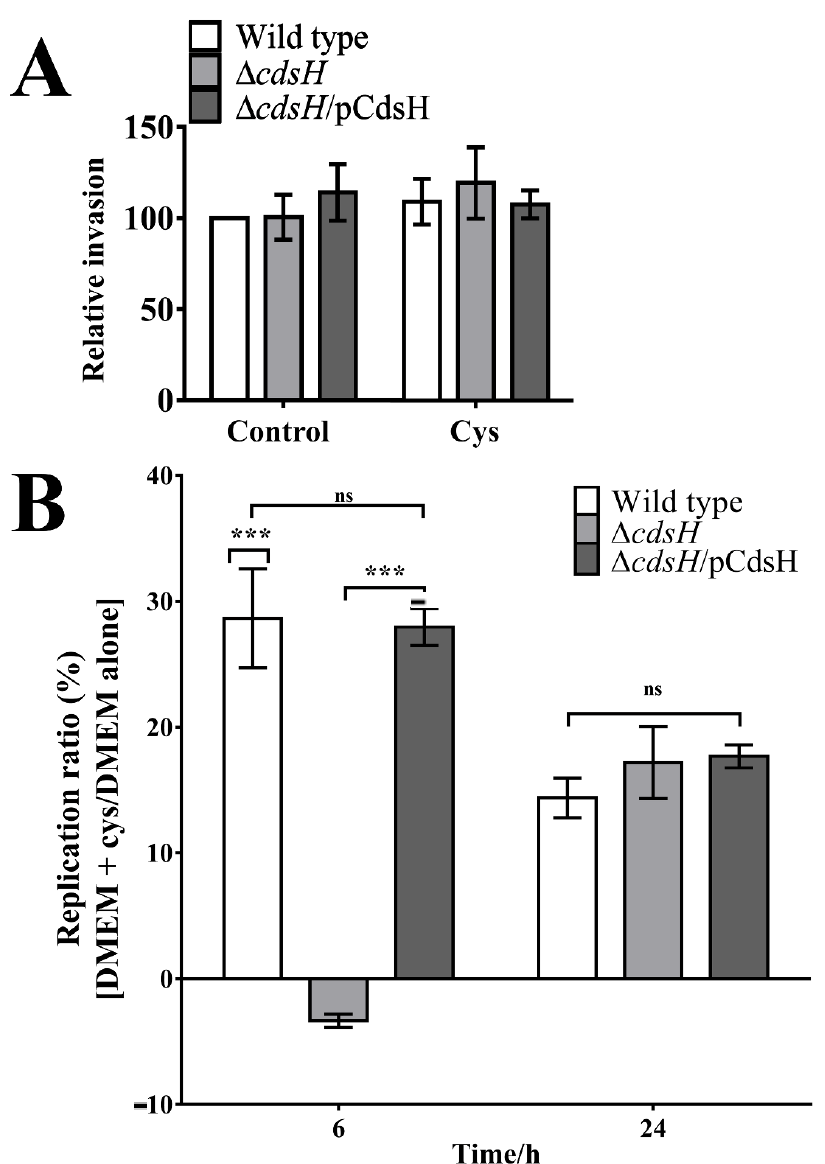
Figure 3. S. Typhimurium replication in HT-29 cell line with and without cysteine. HT-29 cell line cultures in 96-well plates were infected with wild type, ∆ cdsH , or ∆ cdsH / pCdsH strains in DMEM medium alone or supplemented with 0.2 mM cysteine. ( A) Three hours post-infection (relative invasion related to the wild type strain); ( B ) Six and twenty-four hours post-infection (early and late replication). The Figure Shows the percentage replication ratio of DMEM + cys:DMEM alone. Bacteria were recovered from the intracellular environment by disrupting cells with 0.5% sodium deoxycholate prior to plating on LB agar to count CFU. Two-way ANOVA (post hoc: Tukey) was performed for analysis (error bars represent standard error of the mean, n = 5; ns, no significance; ***, p <